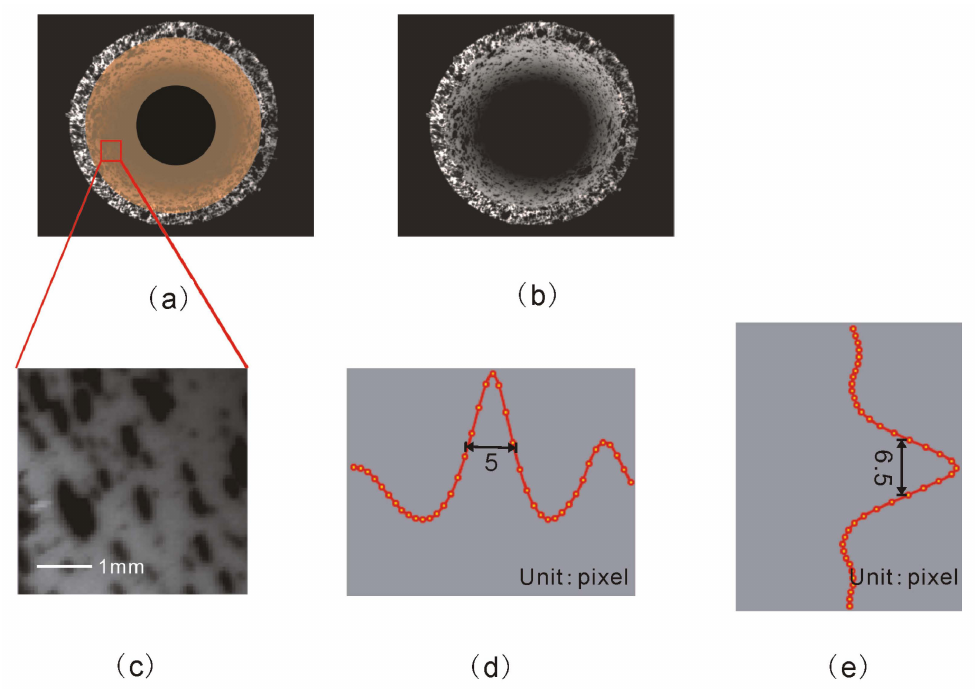
Figure 11. Collected images and speckle texture analysis: ( a ) image of camera A, ( b ) image of camera B, ( c ) typical areas of the subregion, ( d ) full width of horizontal half-peak, and ( e ) full width of vertical